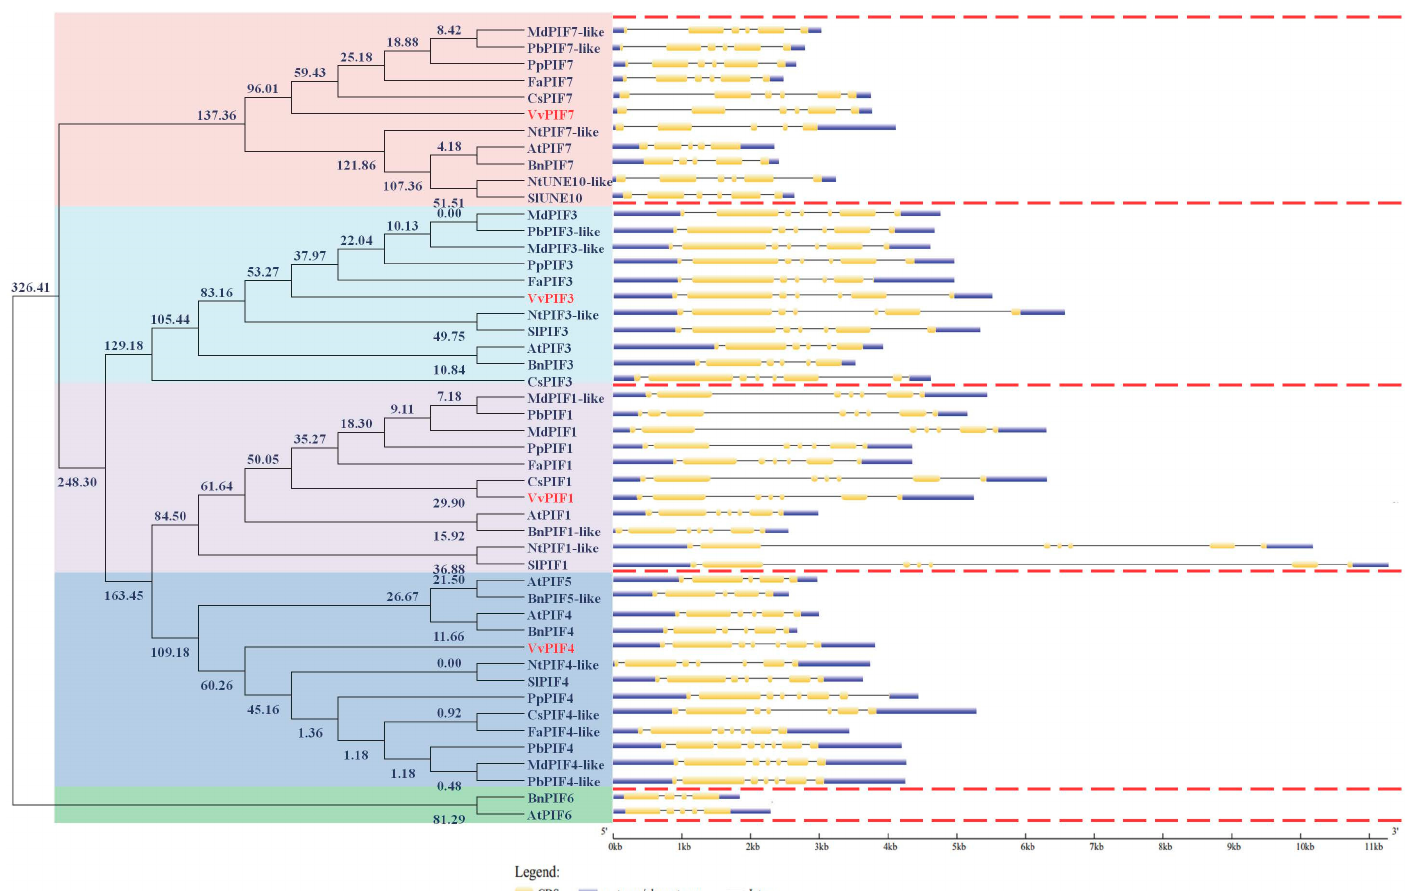
Figure 1. The phylogenetic tree of PIF proteins and their gene structure characteristics. Members of PIFs from the Vitis vinifera (red mark), Arabidopsis thaliana , Brassica napus , Nicotiana tabacum , Solanum lycopersicum , Prunus persica , Malus domestica , Pyrus bretschneideri , Citrus sinensis , and Fragaria ananassa were put together for comparison. The phylogenetic tree was generated by MEGA 6.0 using Maximum Likelihood method (timetree). The axis numbers mean the relative divergence time. CDS: Coding sequence.